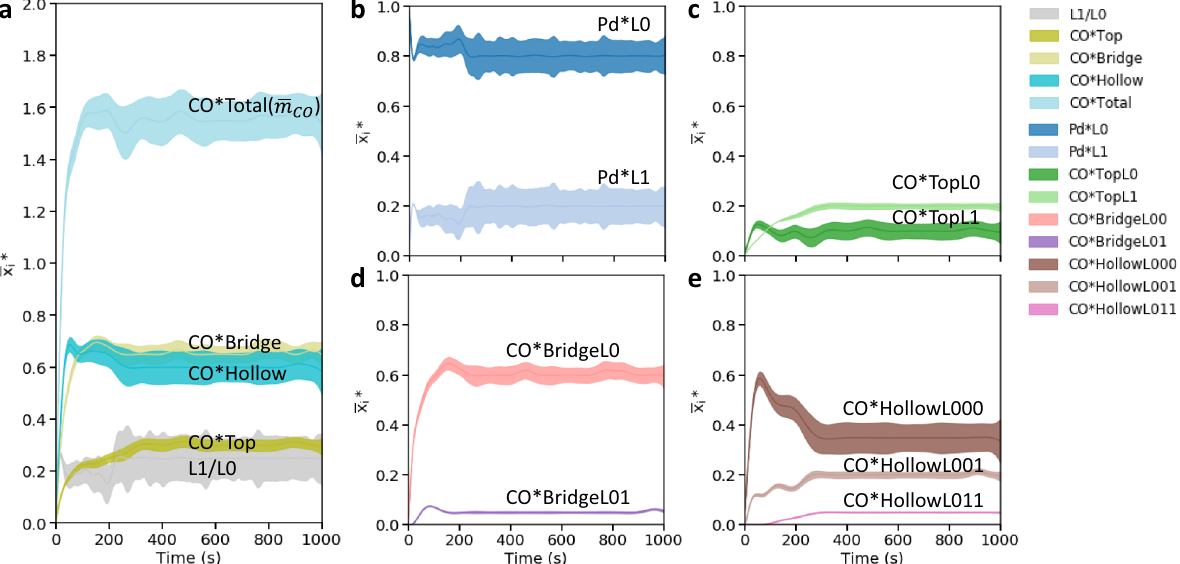
Fig. 3 Species ratios as a function of time at 300 K exposed to a CO partial pressure P CO = 0.1 bar. a L1/L0 ratio — the number of Pd atoms in the L1 layer to the number in the base L0 layer, x i * — the ratio of total CO adsorbate counts on top, bridge, and hollow sites to the number of Pd atoms vs. time. b x i * — the ratio of Pd atom counts on various Pd sites and c – e CO adsorption adsorbate counts on various CO adsorption sites to the number of Pd atoms vs. time. The means and 95% con fi dence intervals over the triplicate runs are shown with solid and shaded areas, respectively. A zoomed-in version for the fi rst 60 s is in Supplementary Fig. 1. Simulations starting from a 0.05 coverage of single